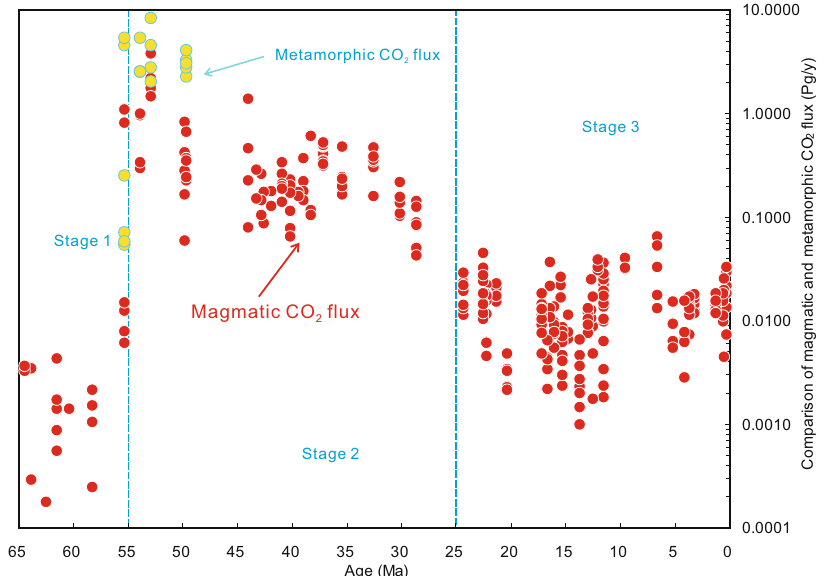
Fig. 6 Three-stage evolution of magmatic and metamorphic CO 2 outgassing rates. Each fi lled red and yellow dot denotes a calculation result of the magmatic and metamorphic CO 2 outgassing rate by CCFM, respectively, based on a set of geochemical data (including major element, trace element and Sr – Nd – Pb isotope composition) of each sample from 287 samples (for detailed calculation procedures see “ Methods ” and Supplementary Data 2), which have been distributed in 55 volcanic fi elds in Tibetan Plateau in the Cenozoic (Fig. 1). 1 Pg = 10 15